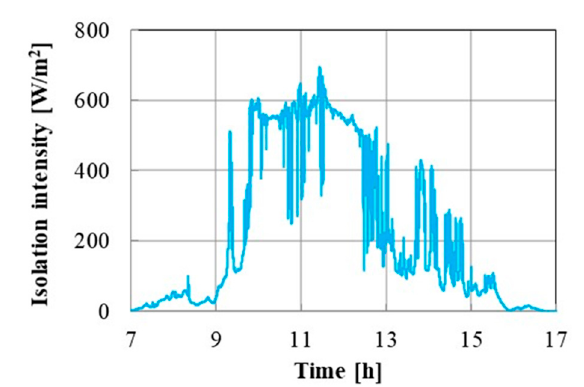
Figure 17. Insolation intensity on December 8, 2016.